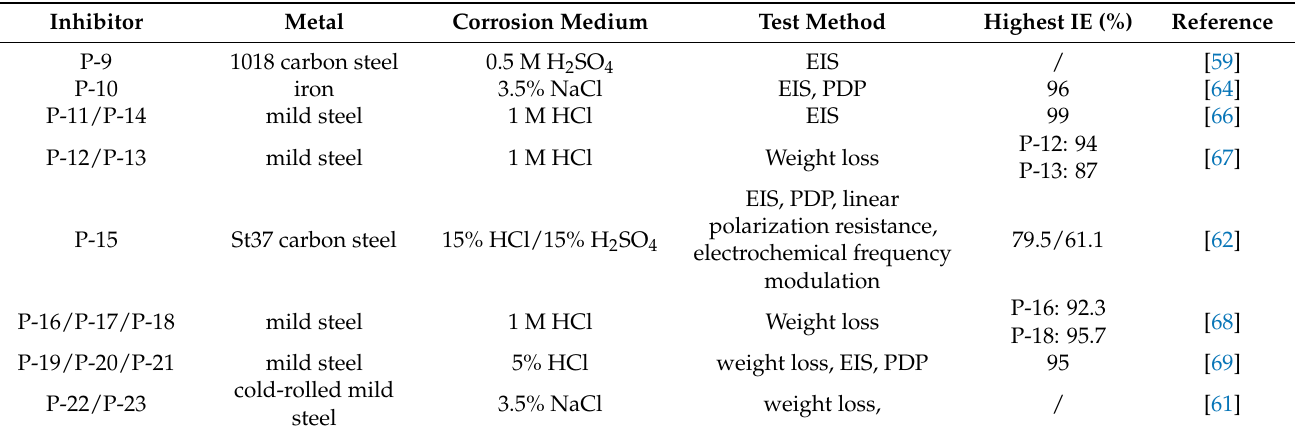
Table 3. Inhibition property of typical sulfur-containing synthetic polymeric